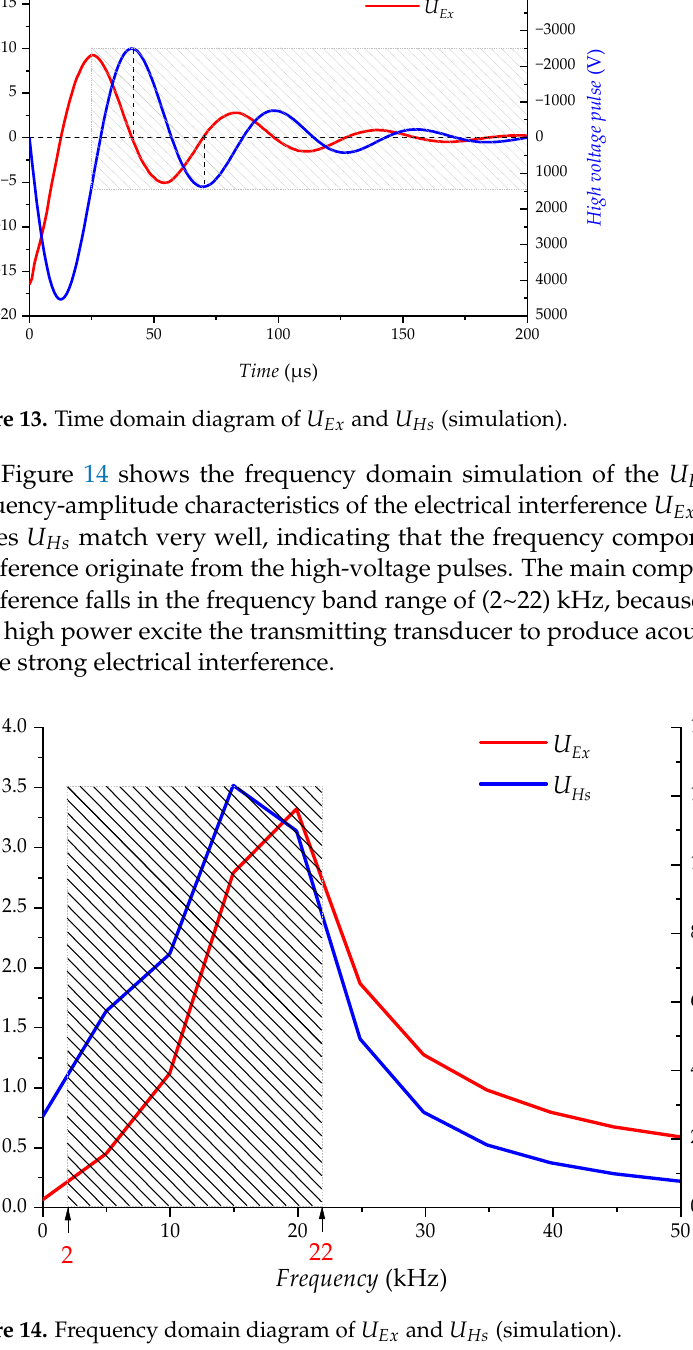
Figure 13. Time domain diagram of